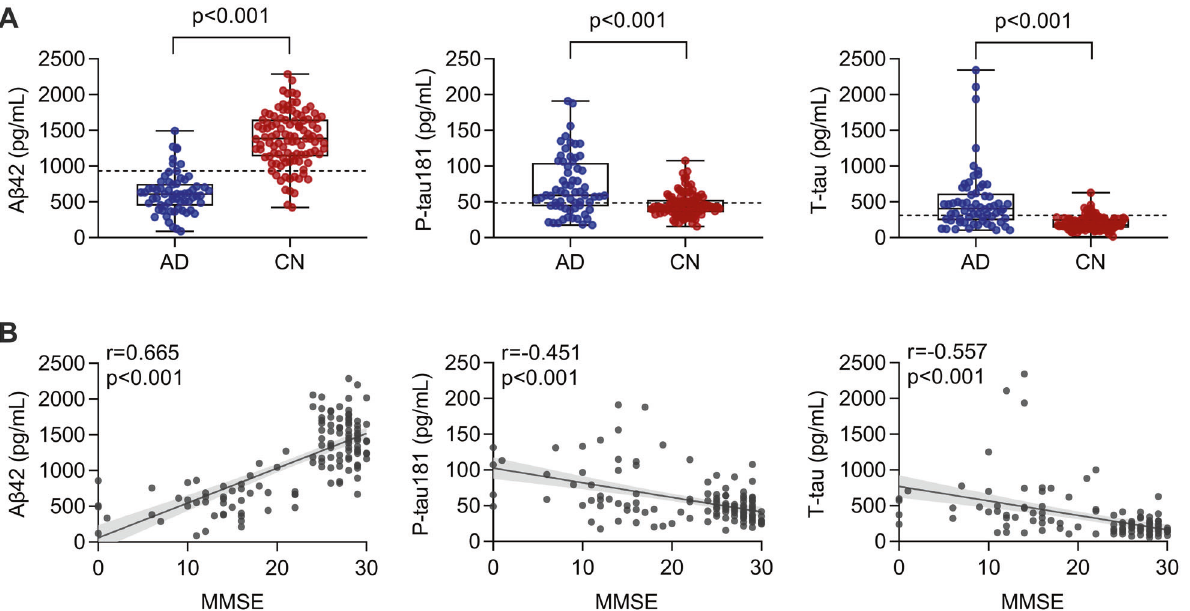
Fig. 1 Comparison of single CSF biomarkers and their correlation with MMSE scores. A Comparison of CSF A β 42, P-tau181, and T-tau between AD ( n = 64) and CN ( n = 105) group. Boxes represent the 25th, 50th, and 75th data percentiles. Whiskers represent the lowest and highest data. The dashed lines indicate the cutoff values for each biomarker. B Correlations between CSF A β 42, P-tau181, T-tau, and MMSE scores. The best- fi t linear regression line is shown and 95% con fi dence intervals are superimposed. MMSE, mini-mental state examination; AD, Alzheimer ’ s disease; CN, cognitively normal.